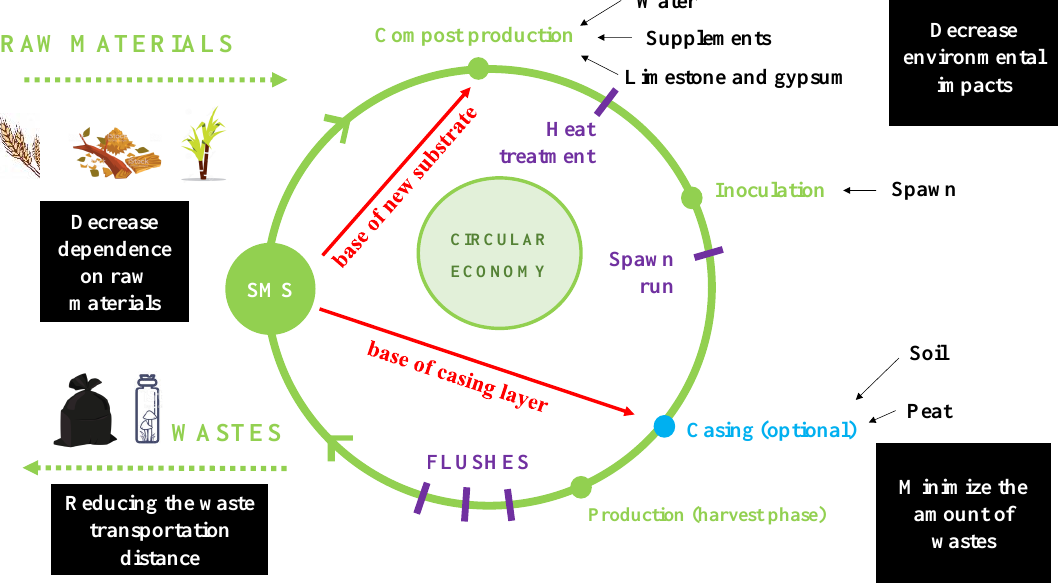
Figure 2. Mushroom circular economy representing the beginning of the process with the introduction of raw materials, going through compost production, inoculation and production phase (three harvest flushes) until the end of cultivation, where the only waste of the cycle is the plastic bags/bottle. Red letters and arrows indicate the reuse of SMS in the formulation of new substrates and in the casing layer.